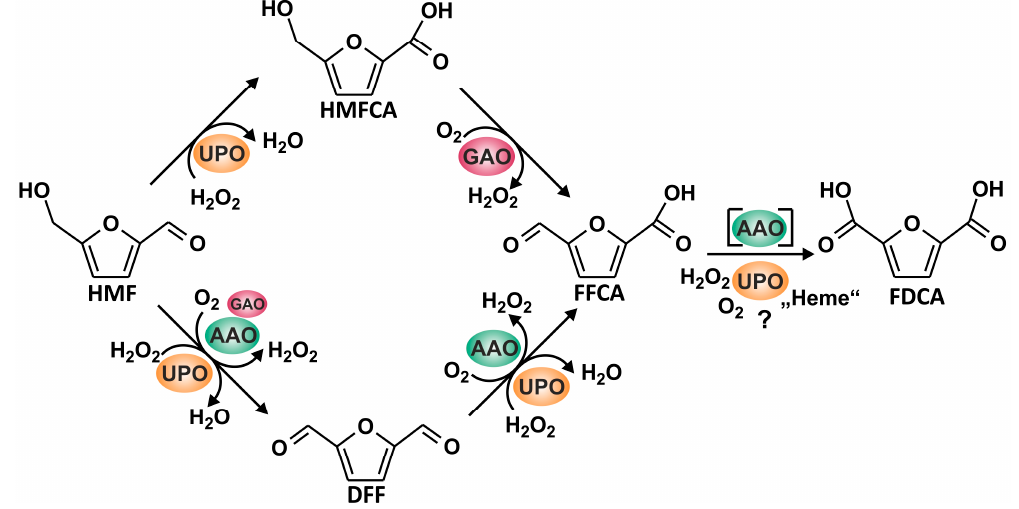
Figure 5. Reaction sequence leading from HMF to FDCA realized by the joined action of AAO, GAO, and Aae UPO.